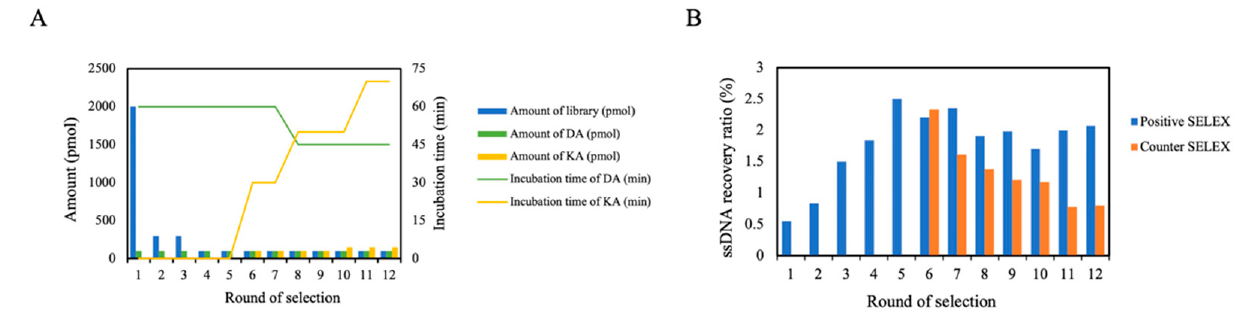
Figure 2. ( A ) Selection conditions of Capture-SELEX. ( B ) The recovery ratio of ssDNA in Capture- SELEX. The recovery ratio represents the percentage of the amount of ssDNA eluted by the target to the amount of library immobilized in this round.